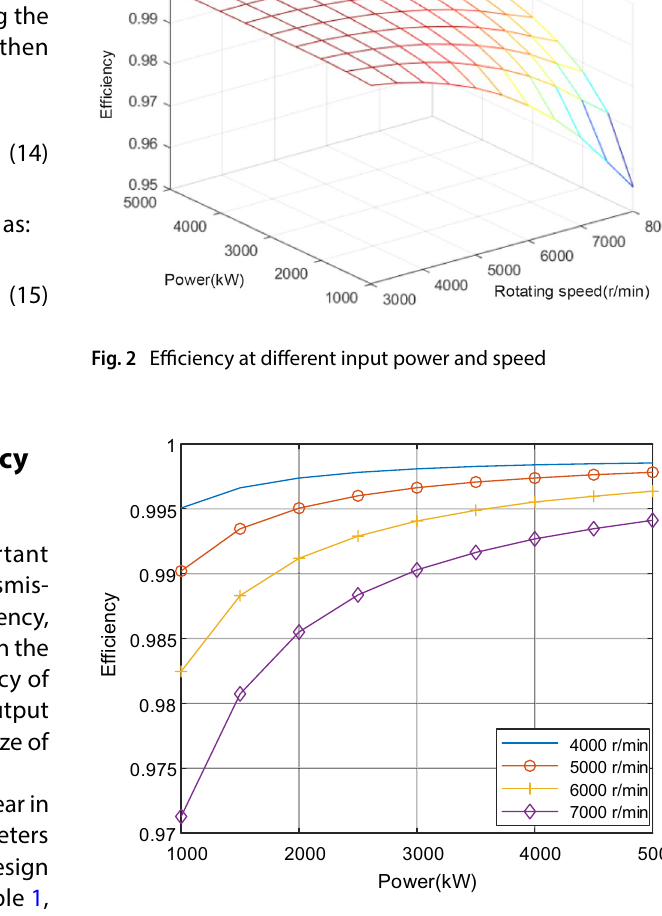
Fig. 3 Efficiency at different input power with constant